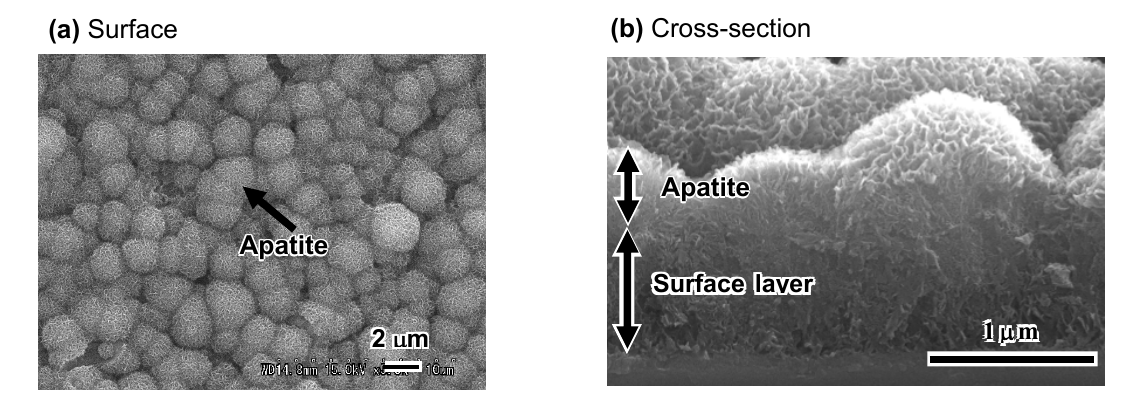
Figure 5. SEM photographs of surface (a) and cross-section (b) of NaOH- and heat-treated Ti metal after soaking in SBF for 1 d.